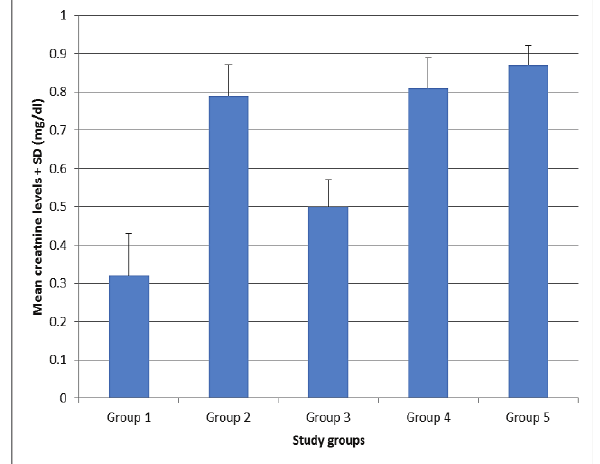
Fig-B: Mean creatinine level in five study groups at 24 th day